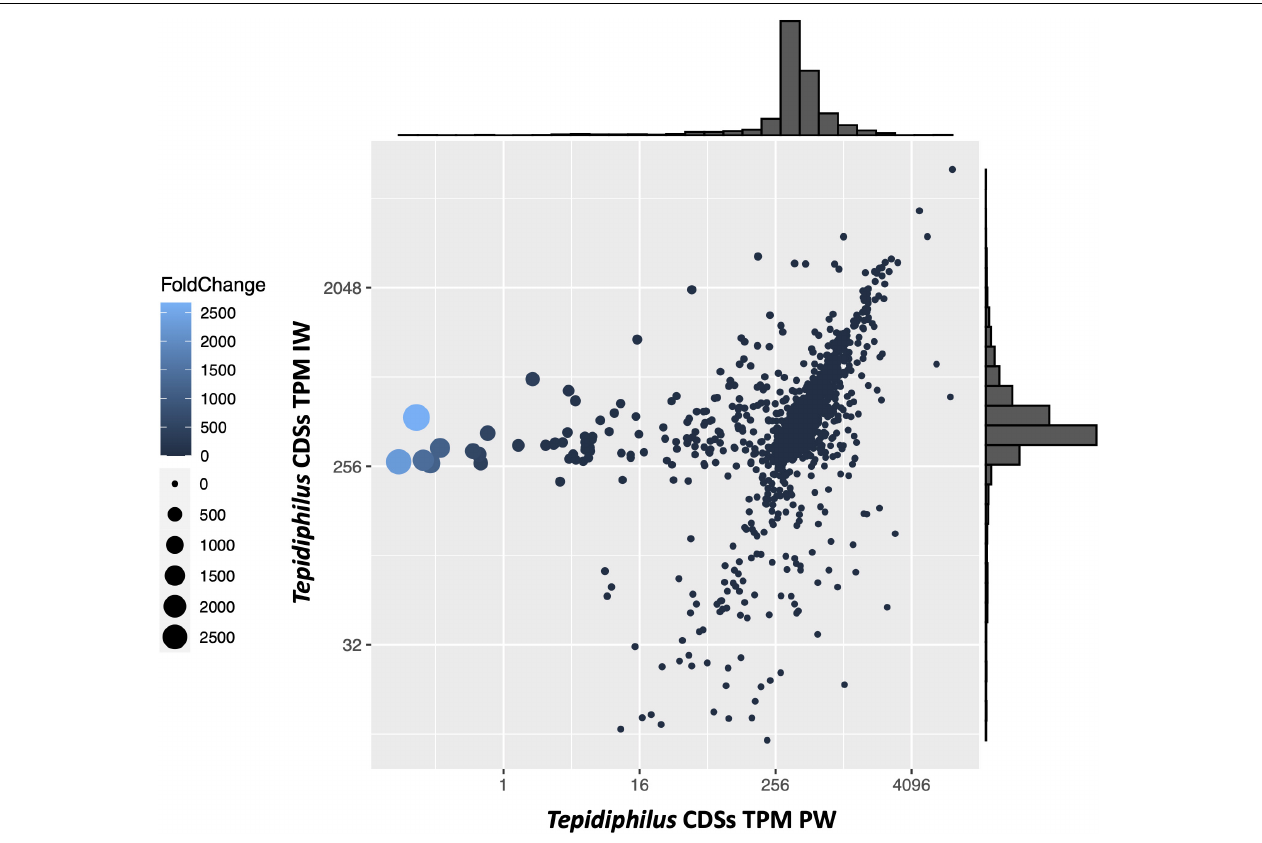
FIGURE 7 | Tepidiphilus CDS relative abundance using TPM. The X and Y -axes represent the calculated TPM for each CDS for the PW and IW, respectively. Both axes are log2 transformed. Dot size and the lighter color are proportional to the CDS fold change: The bigger the dots or lighter the color, means higher fold change. Outer histograms represent the frequency of scaffolds in each region of the